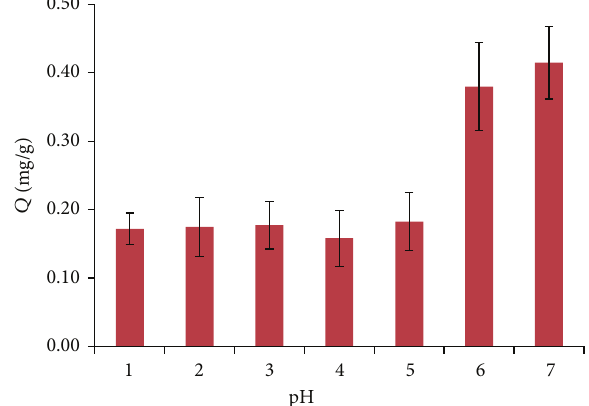
Figure 2: Effect of pH on the extraction efficiency ( 𝑄 ) of Sr 2+ . Extraction conditions: absorption time 20min, 35 ∘ C, and stirring rate 600